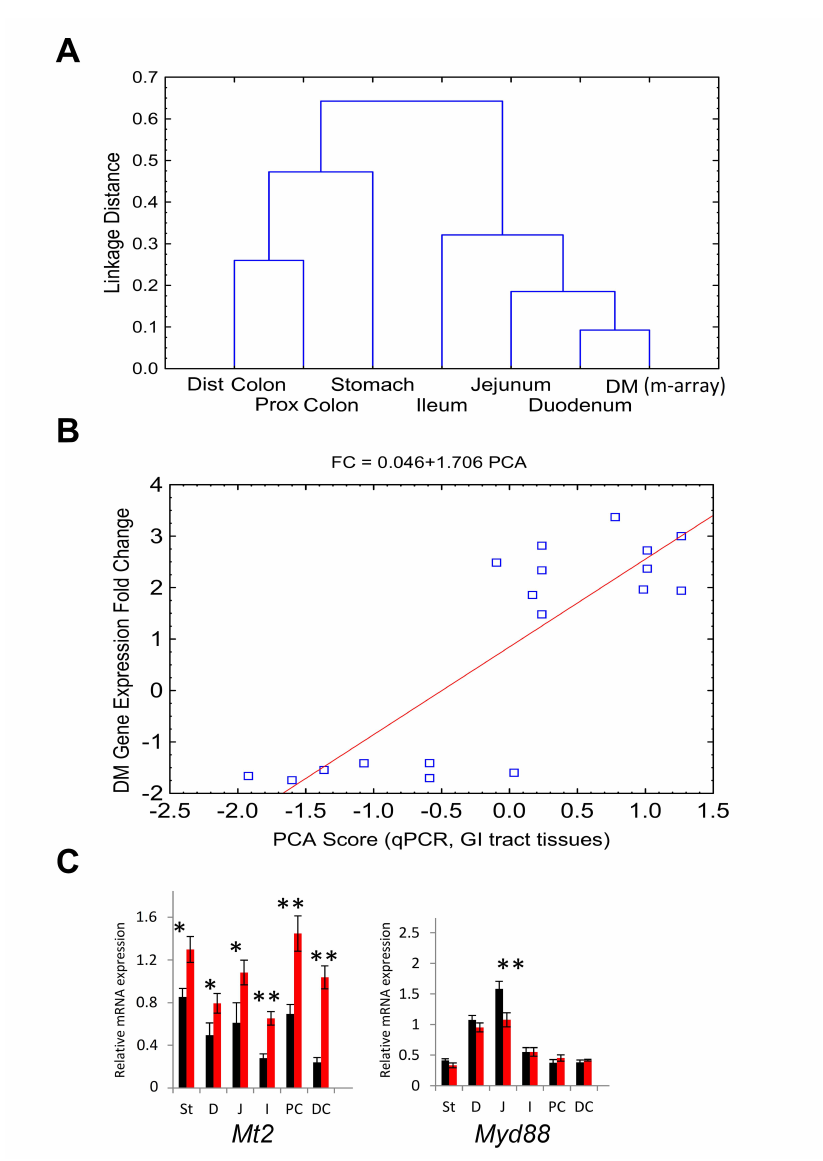
Figure 8. Comparing GI tract tissues responses to CR defined by qRT-PCR. ( A ) Hierarchical cluster analysis, showing two distinct GI tract clusters after calculating the distance between tissues in the CR qPCR response of 18 genes. ( B ) Principal component analysis (PCA) of the six gastrointestinal (GI) tract tissues. ( C ) Relative mRNA expression of Mt2 and Myd88 measured in six tissues along the GI tract. Two-tailed Student’s t -tests were used to assess statistical significance; n =7–14, * p <0.05, ** p <0.01. St-stomach, D-duodenum, J-jejunum, I-ileum, PC proximal colon, DC distal colon. CR induces significant over-expression of Mt2 across all studied tissues. Mt2 is one of a few immune system genes upregulated upon CR in DM. The qPCR-defined expression pattern of Myd88 shows it is likely not sensitive to CR among five of six GI tract